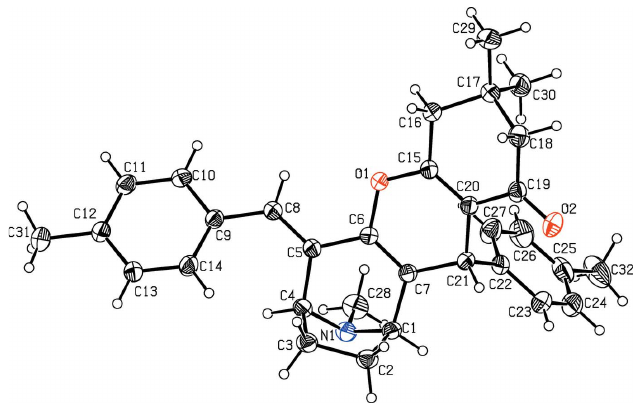
Figure 1 A view of the molecular structure of compound (I), showing the atom labelling. Displacement ellipsoids are drawn at the 30% probability level.